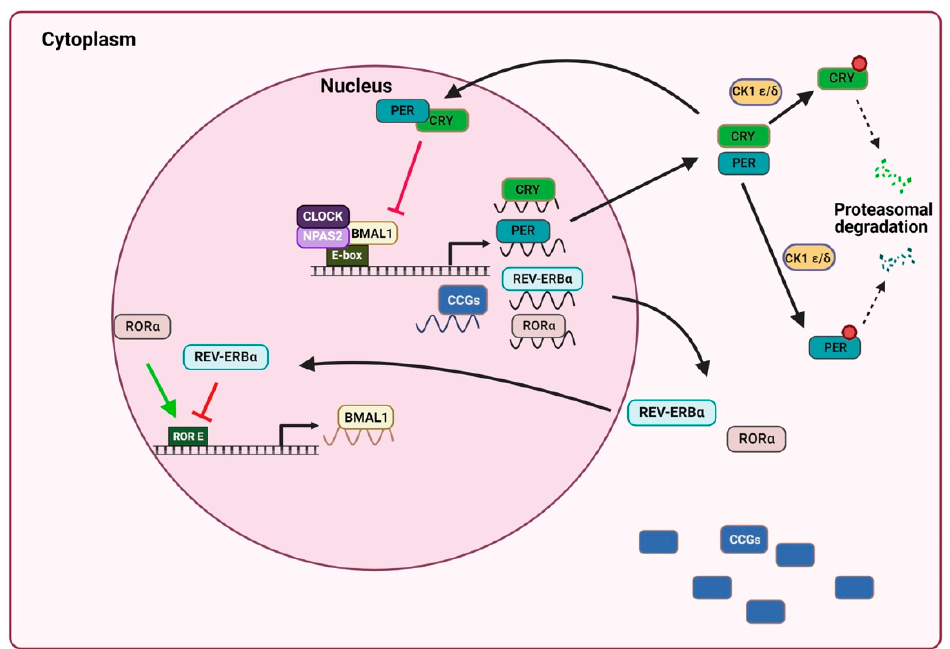
Figure 1. Schematic model of mammalian circadian clock mechanism. The molecular clock is composed of interconnected transcription feedback loops: the transcription factors CLOCK/NPAS2 and BMAL1 produce a heterodimer that binds to the E-box in the promoter and activates the transcrip- tion of Per, Cry, Rev-erb α , Ror α and CCGs. CRY and PER dimerize and enter the nucleus, where CLOCK-BMAL1-activated transcription is inhibited, thus generating an oscillatory pattern of gene expression. In the cytoplasm, PER and CRY are phosphorylated by CK1 ε / δ for its degradation. The REV-ERB α receptor inhibits Bmal1 expression, while ROR α positively regulates Bmal1 expression. Brain and muscle aryl hydrocarbon receptor nuclear translocator-like protein 1 (Bmal1); cysteine kinase 1 ε / δ (CK1 ε / δ ); circadian locomotor output cycles kaput (Clock); cryptochrome (Cry); neu- ronal PAS domain protein 2 (NPAS2); Period (Per); reverse strand of protein ERB alpha (Rev-erb α ); orphan retinoic acid receptor-related alpha (ROR α ). Image created using BioRender.com (accessed on 22 November 2022). 3. Clock Genes and Cancer Alterations in clock genes are associated with different types of human cancer [20– 23]. However, it is not understood how circadian disruption is associated with serious adverse health outcomes, including carcinogenesis. The World Health Organization currently recognizes night shift work, which in- volves circadian disruption, as a probable carcinogen, classified as type 2A by the Agency for Research on Cancer (IARC) [24]. Since the 1980s, numerous epidemiological studies have linked an increased risk of different cancers, such as breast and prostate cancer, with night shift work by employees such as nurses and flight attendants on transatlantic flights [1,10,12,25]. It has been suggested that sleep deprivation, the light-induced suppression of melatonin and lifestyle changes are important mechanisms that could explain the pos- sible link between shift work and cancer risk [24]. Moreover, studies of genetic variations in the circadian pathway in human clock genes have reported that the disruption of circa- dian rhythms is related to an increased risk of cancer [26]. In support of these findings, a significant relationship has been established between different types of cancer, such as breast, lung and prostate cancer, and variations in Bmal1, Clock, ROR α and ROR β . This is due to the fact that clock genes regulate between approximately 50% and more than 80% of mammalian genome genes, including the tumor suppressor gene p53 and the oncogene c-Myc [27,28]. The disruption in the circadian clock is therefore involved in tumor